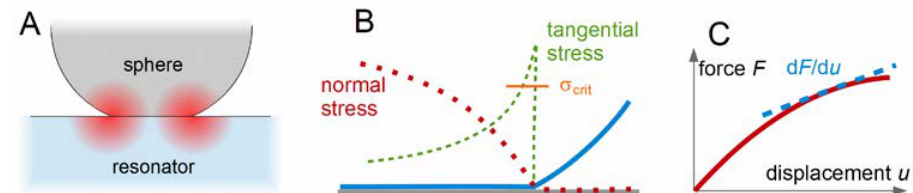
Figure 27. At the edge of a contact under a transverse load (red in ( A )) one often finds a sharp peak in transverse stress ( B ). If the local stress exceeds a certain critical stress, sliding sets in. This is referred to as partial slip [131]. Panel ( C ) sketches the force-displacement relation of a sphere-plate contact with partial slip as calculated with the Cattaneo-Mindlin model [132]. The differential contact stiffness is indicated as a dashed line. It decreases with increasing displacement.